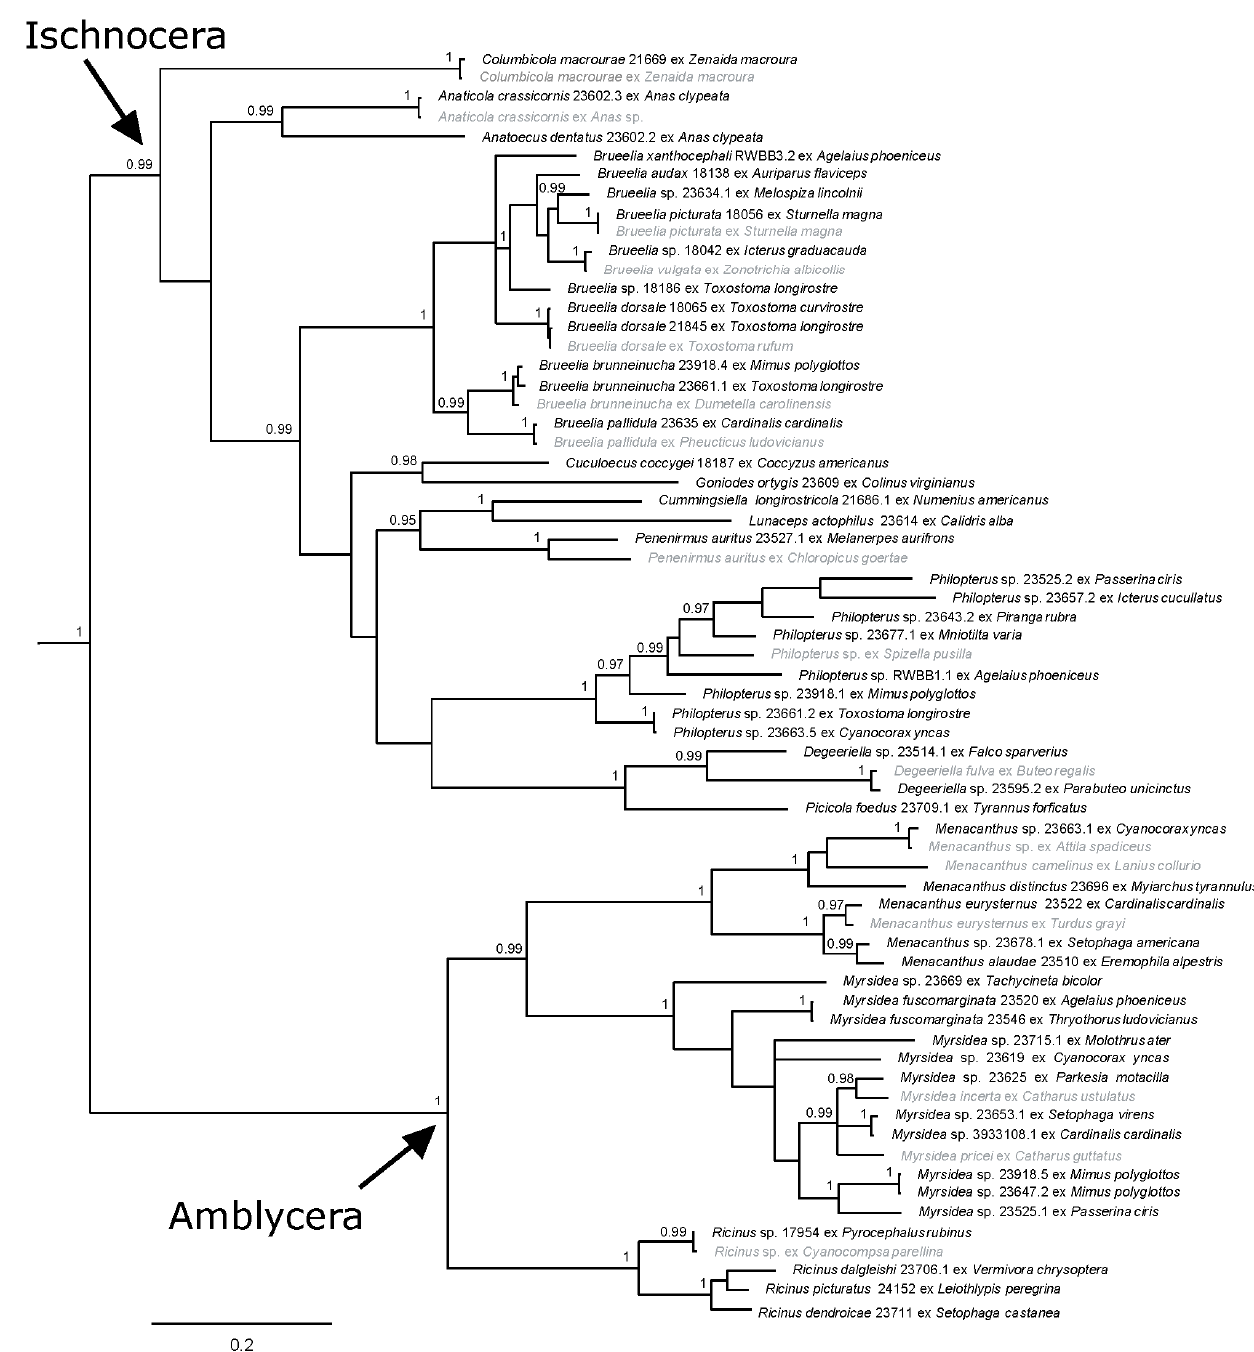
Figure 4. Bayesian phylogram of combined mitochondrial (COI gene) and nuclear genes (18S and EF-1 α ). Posterior probabilities ≥ 0.95 are shown and sequences in gray are from GenBank. Taxon labels for newly sequenced specimens include the louse species (if identified), unique identifier (generally matching the host voucher number), and host species. Taxon labels for GenBank specimens include louse species (if known) and host species. Outgroup taxa have been pruned.